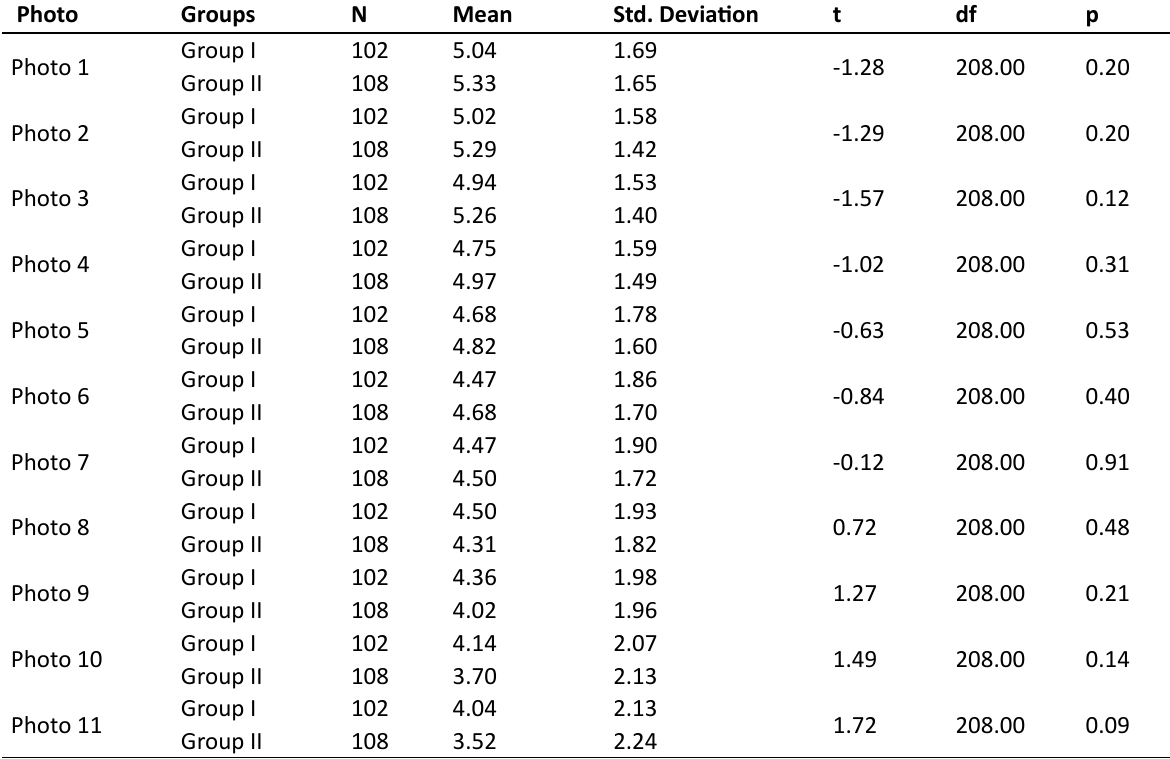
Table 5. Results of Independent Group t-test conducted for determining if the climbing willingness of participators changed according to the climbing level